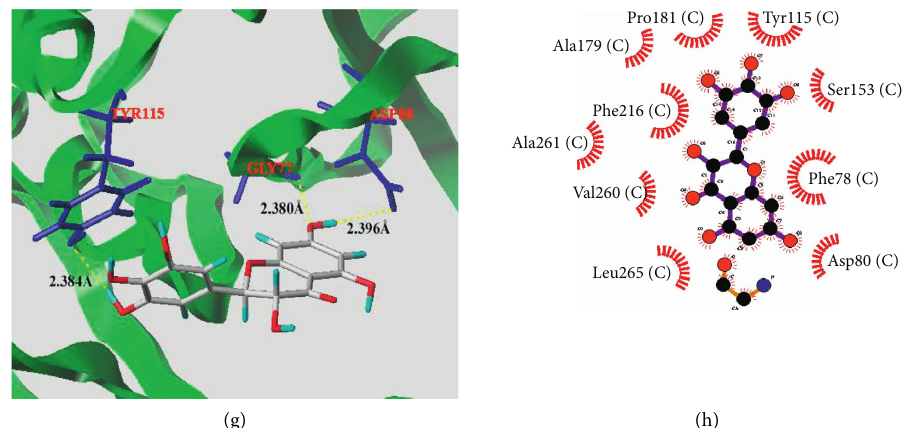
Figure 4: The molecular docking results of myricetrin (a–d) and dihydromyricetin (e–h) with pancreatic